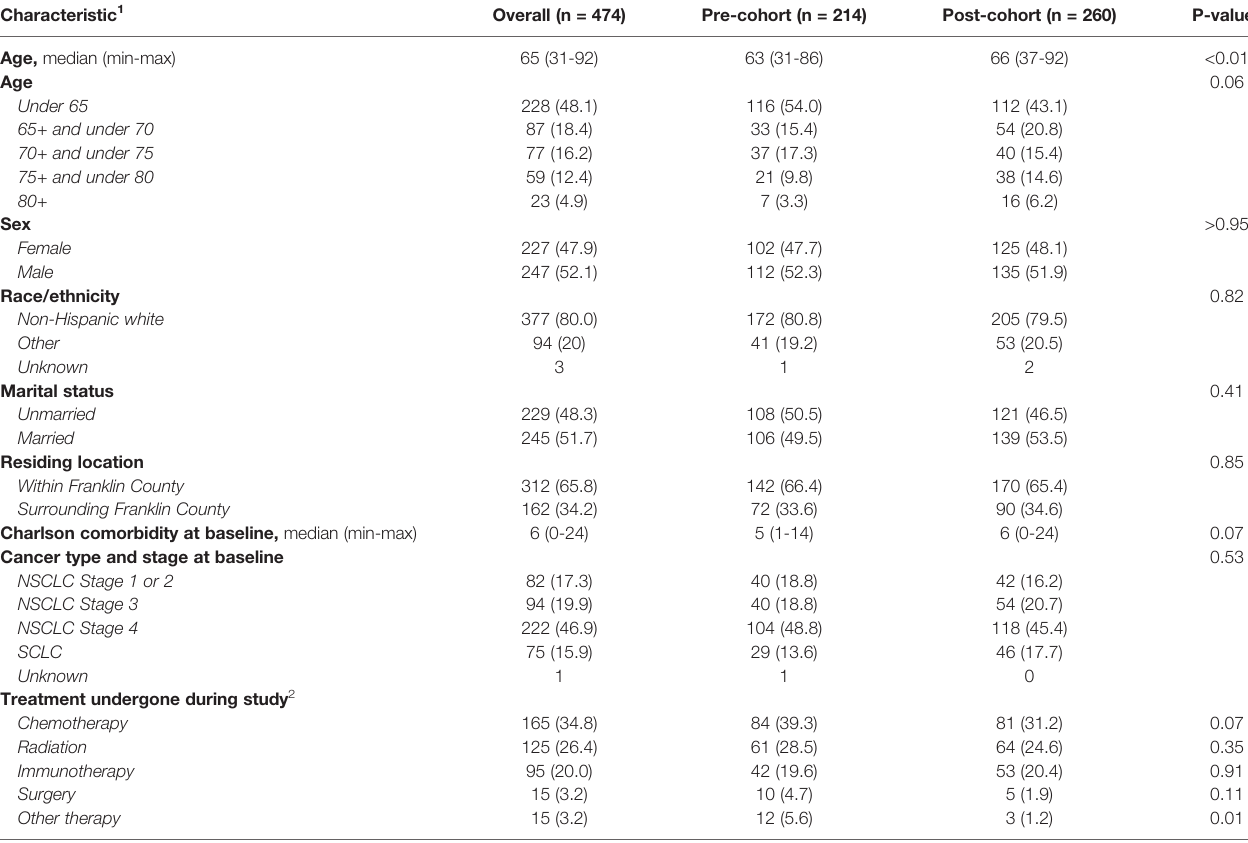
TABLE 1 | Patient characteristics.